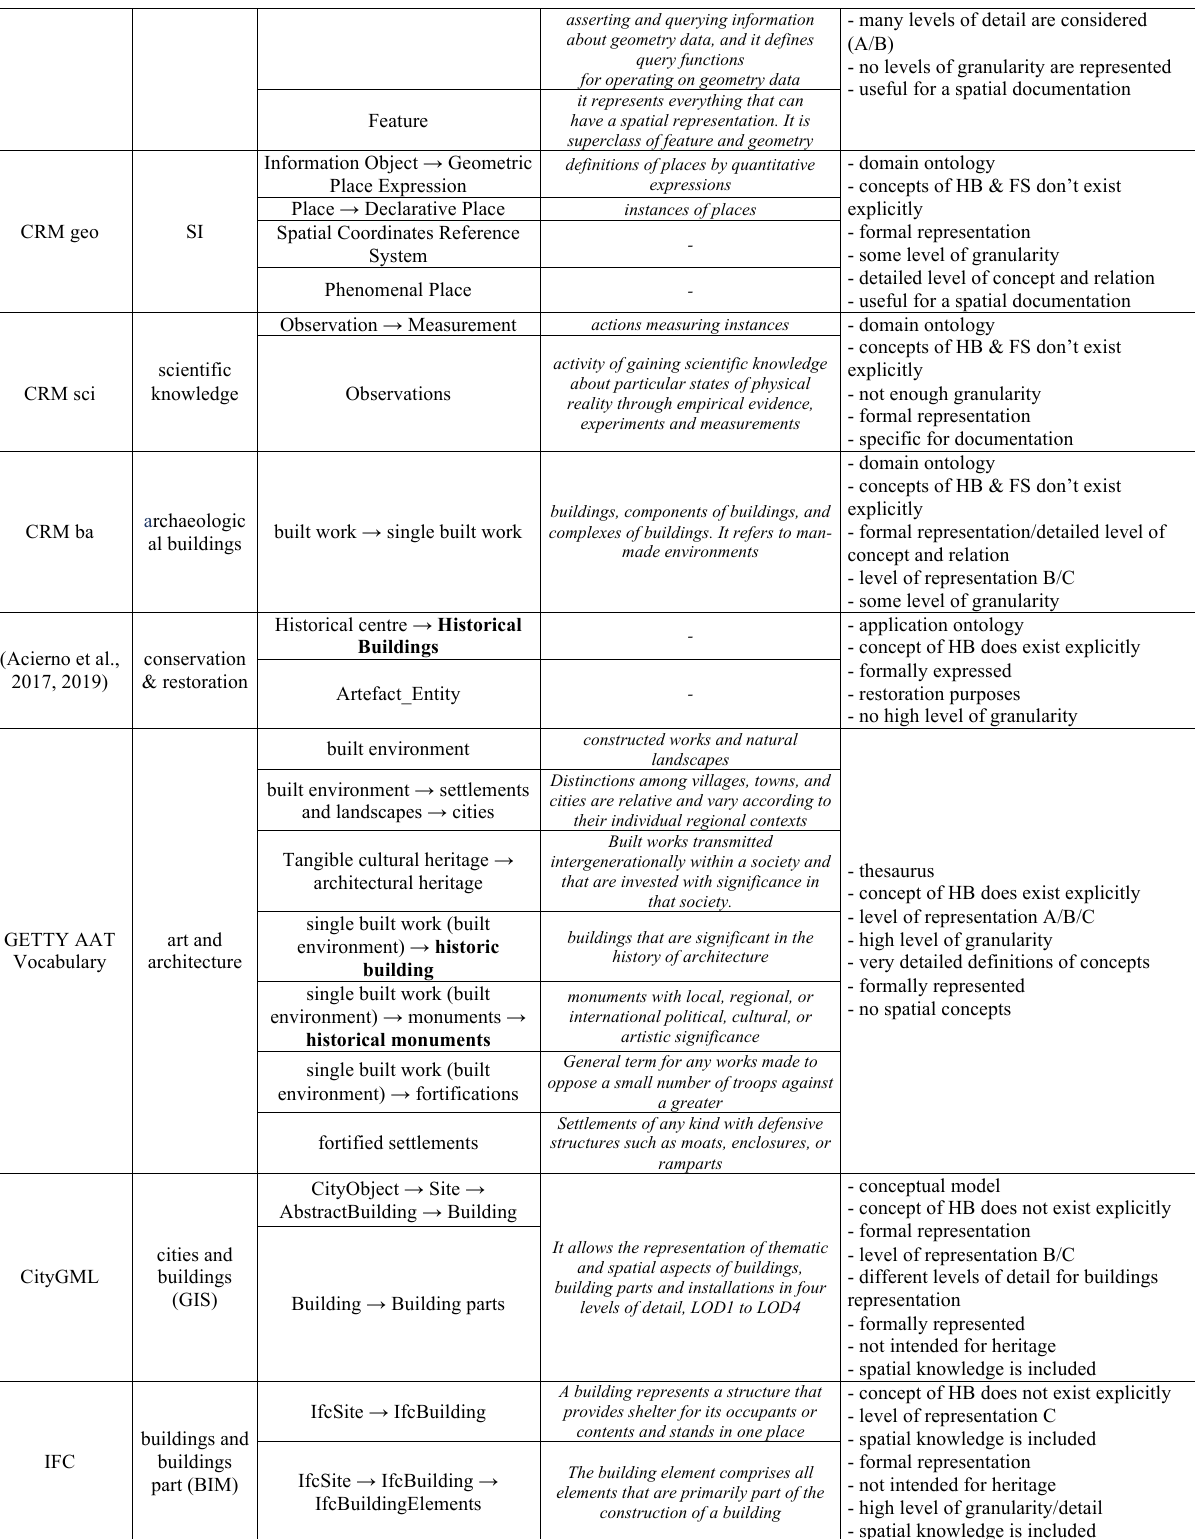
Table 3. Heterogeneity of existing knowledge and standards